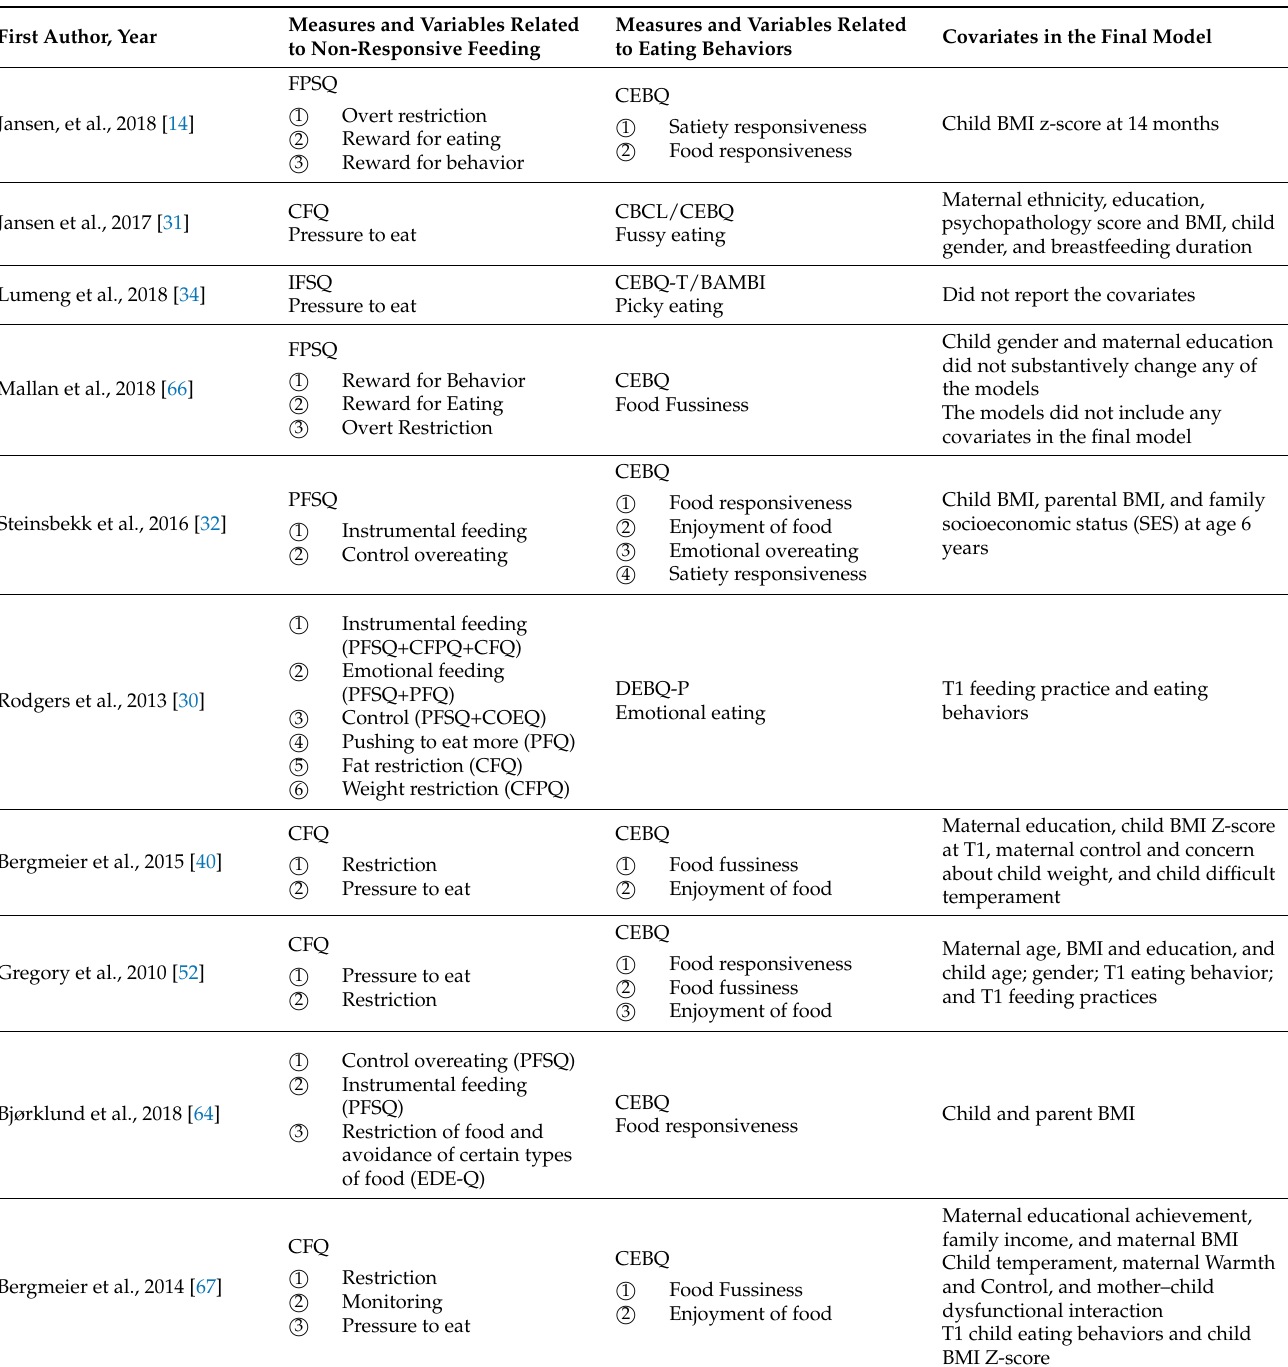
Table 2. Key variables and related measurements ( n =